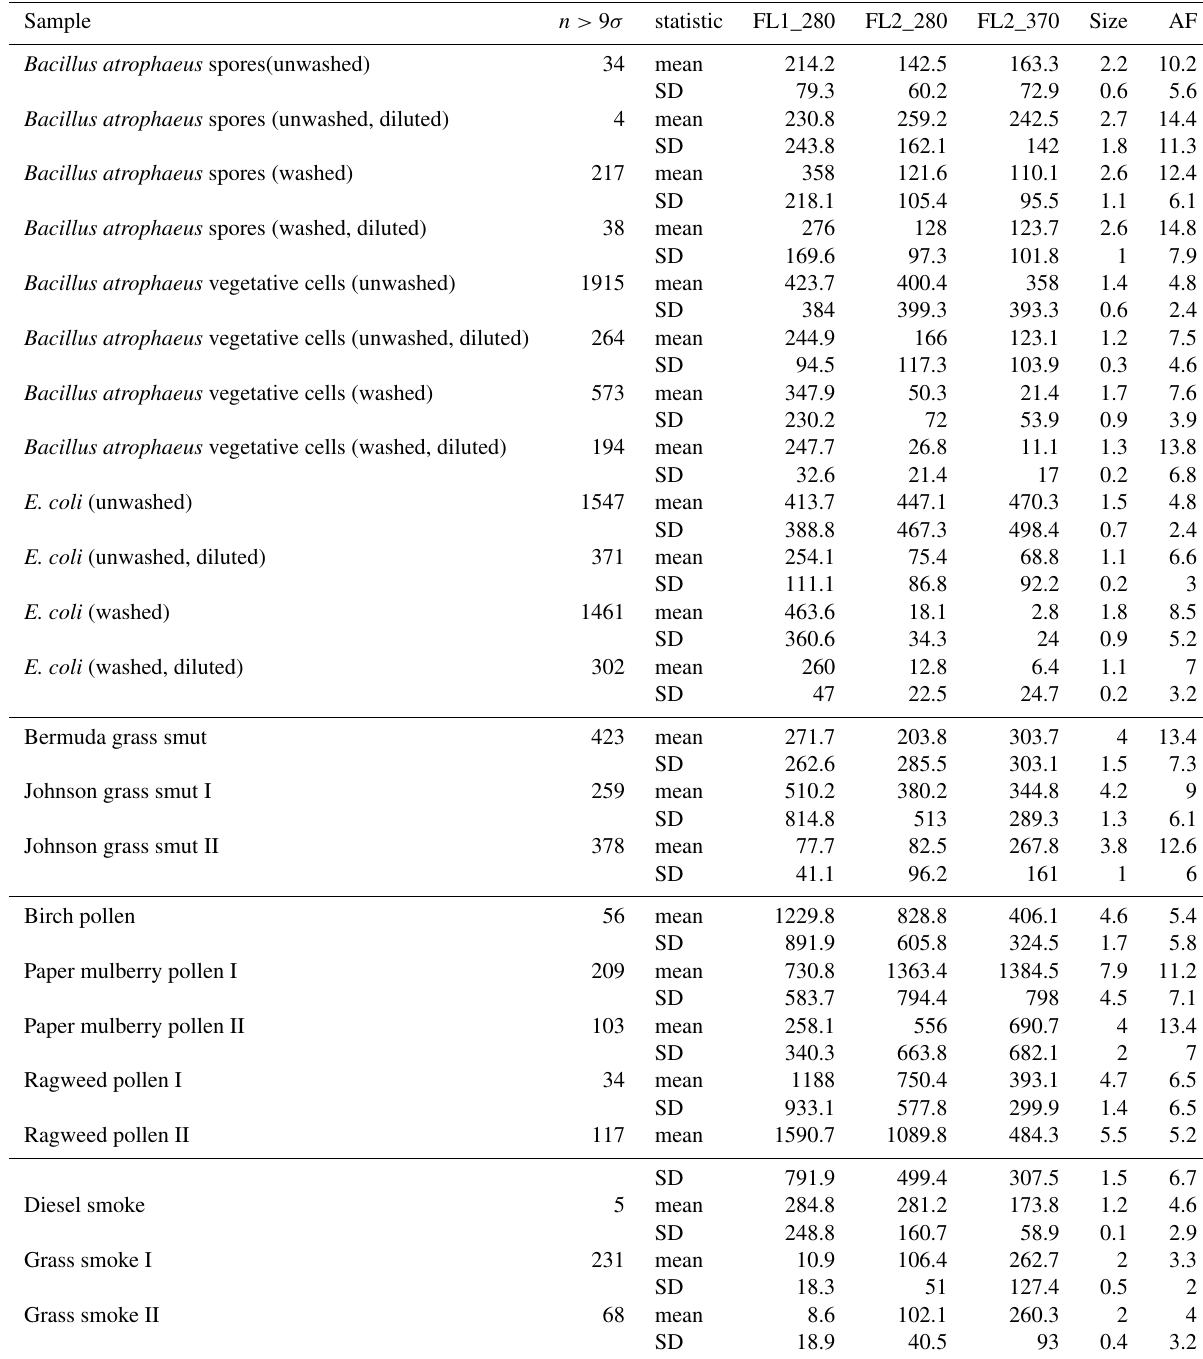
Table C2. Summary of particle measurements for the 2008 data set using a fluorescent threshold of 9 σ .